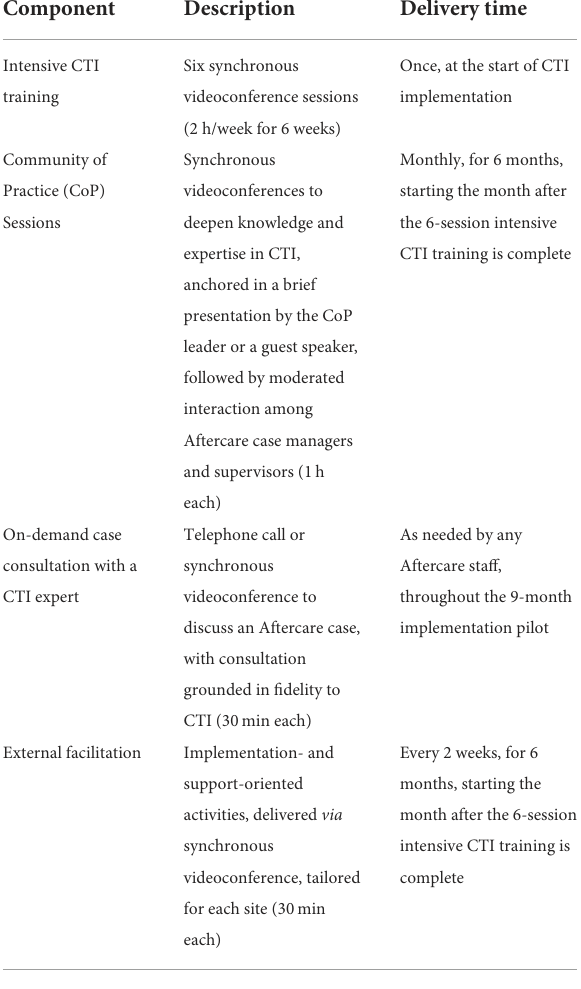
TABLE 2 CTI implementation package piloted at four Aftercare